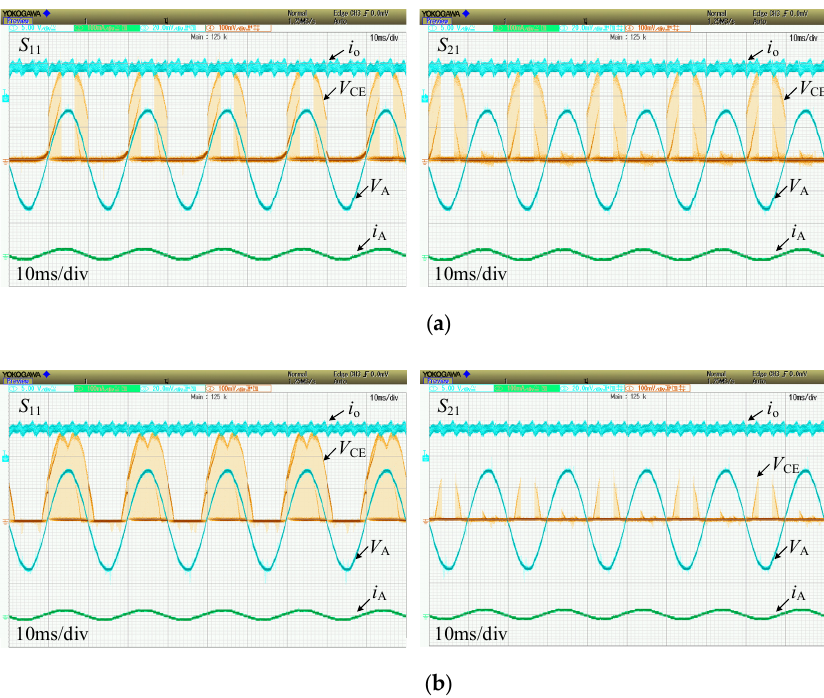
Figure 13. Voltage stress experimental waveforms: input phase voltage V A (50 V/div), input phase current i A (10 A/div), output current i o (2 A/div), and measured voltage stress V CE (50 V/div). ( a ) Conventional standard six-switch CSR. ( b ) Proposed CSR.